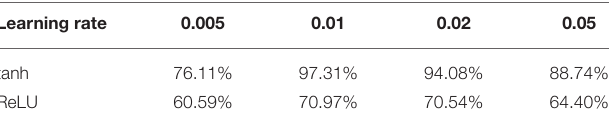
TABLE 1 | Identification accuracy for tanh and ReLU activation functions with different learning rates.